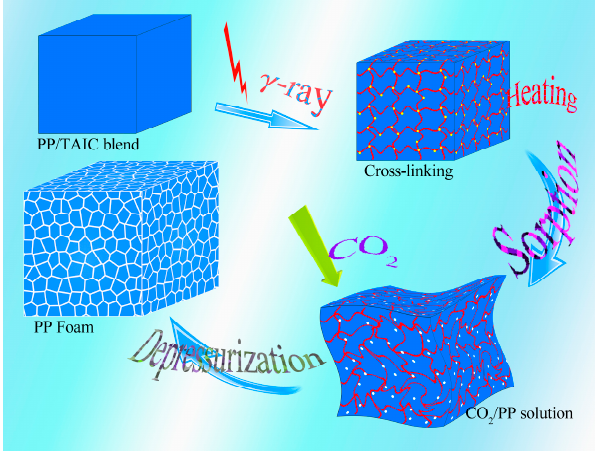
Figure 10. Preparation of microcellular PP foam using the supercritical carbon dioxide ( sc CO 2 ) method.